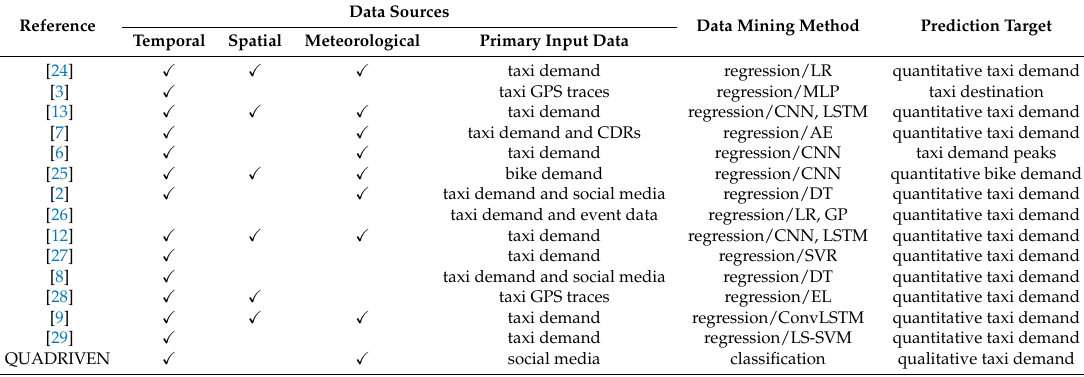
Table 5. Key features of existing prediction models for mobility services. The acronyms’ meaning is as follows: LR, Logistic Regression; MLP, Multi-Layer Perceptron; CNN, Convolutional Neural Network; LSTM, Long Short Term Memory Networks; AE, Auto Encoder; DT, Decision Trees; GP, Gaussian Process and SVR, Support Vector Regression; EL, Ensemble Learning;